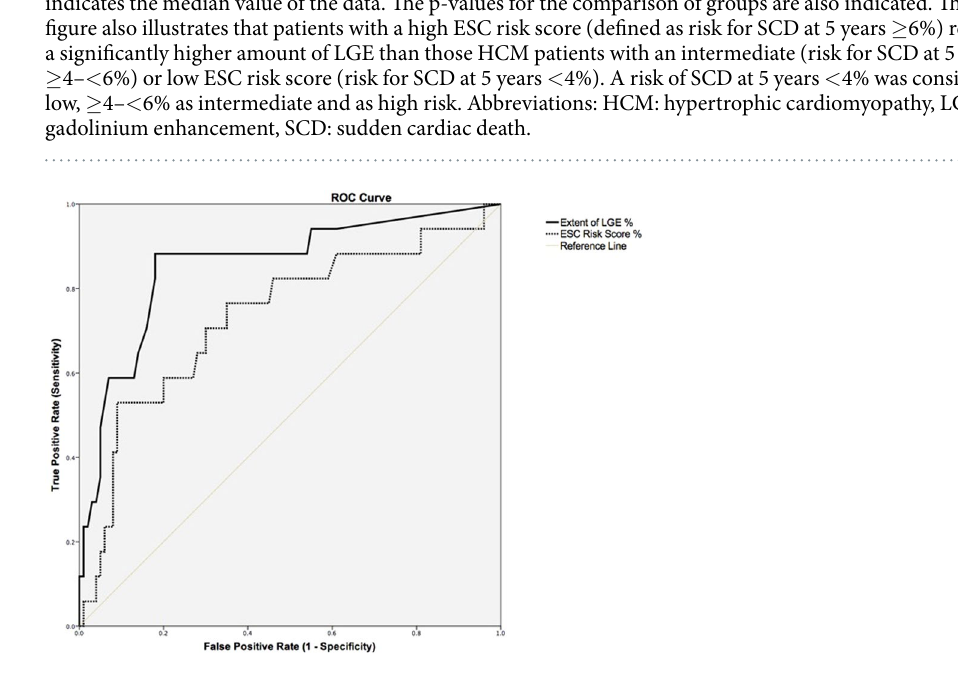
Figure 3. ROC Curves of extent LGE% and ESC risk score to predict major adverse cardiac arrhythmic events in patients with HCM. AUC for extent LGE% was 0.86 (95%CI 0.75–0.96; p < 0.0001) and for ESC risk score was 0.73 (95%CI 0.59–0.87; p = 0.002). ROC indicates receiver operating characteristic; AUC area under curves; HCM, hypertrophic cardiomyopathy; LGE, late gadolinium enhancement; CI, confidence